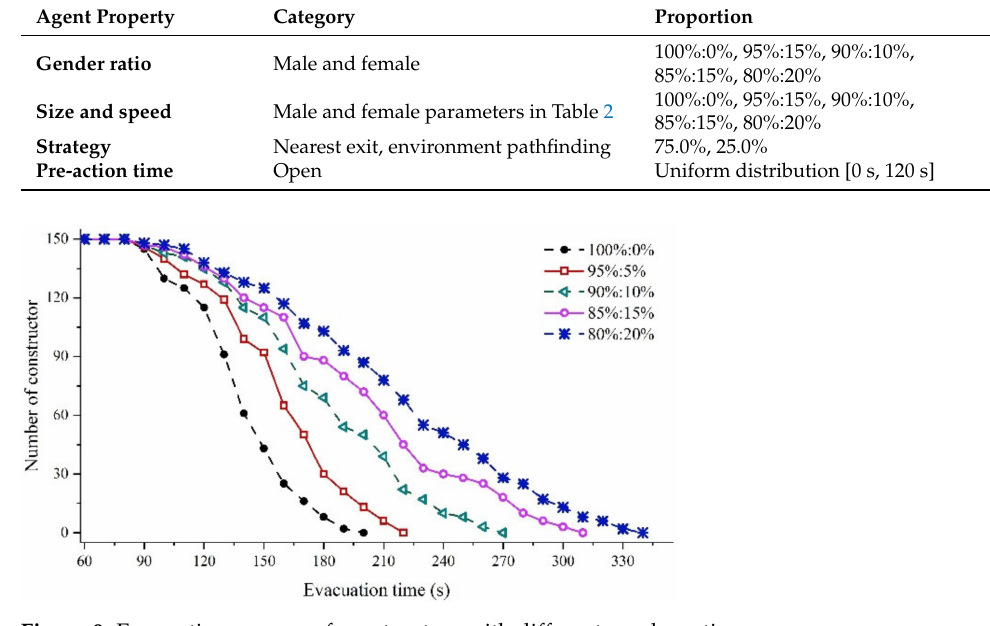
Figure 9. Evacuation process of constructors with different gender ratios.